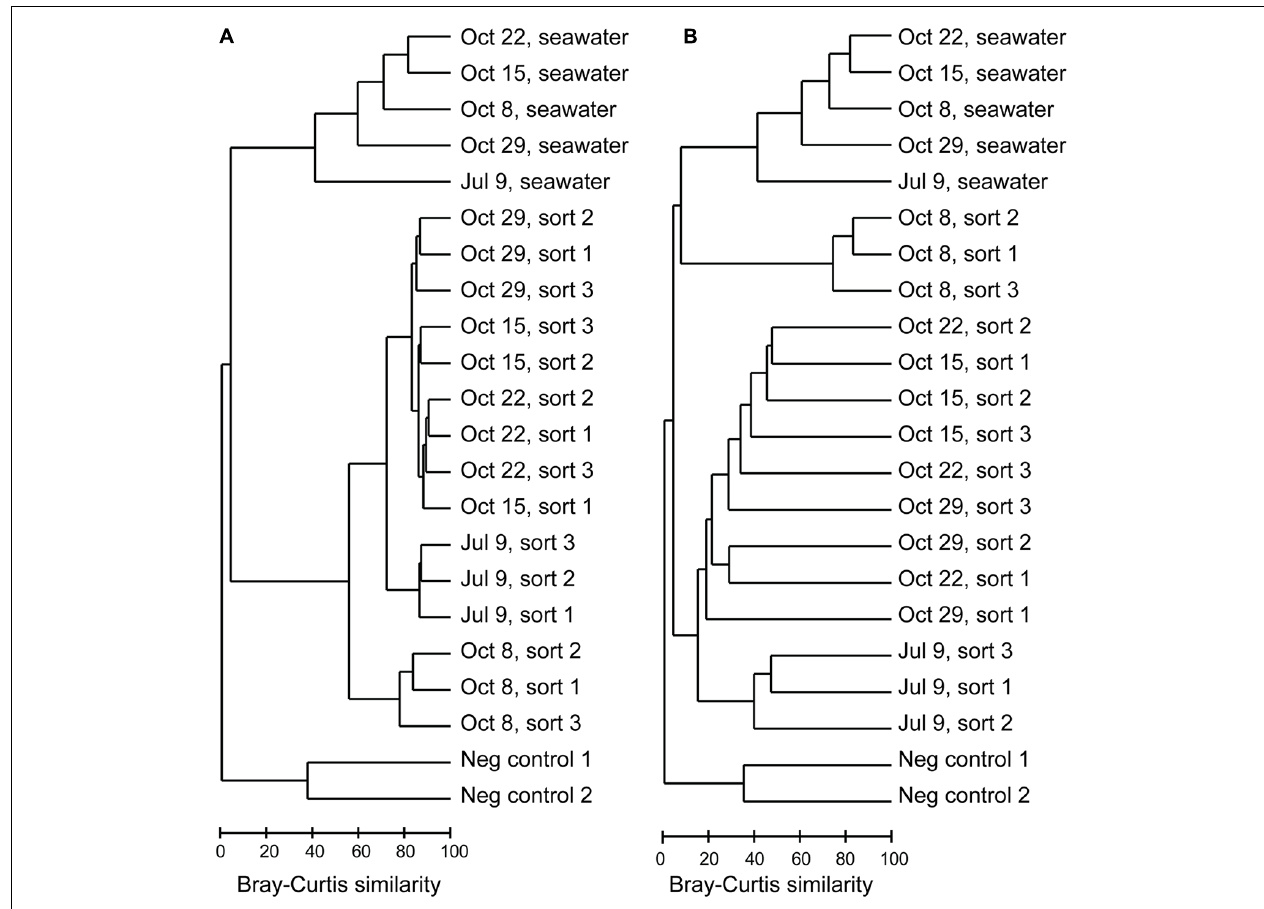
FIGURE 3 | Dendrograms based on Bray–Curtis similarity between Illumina MiSeq 16S rRNA gene libraries for (A) all OTUs, (B) non-Eukaryota